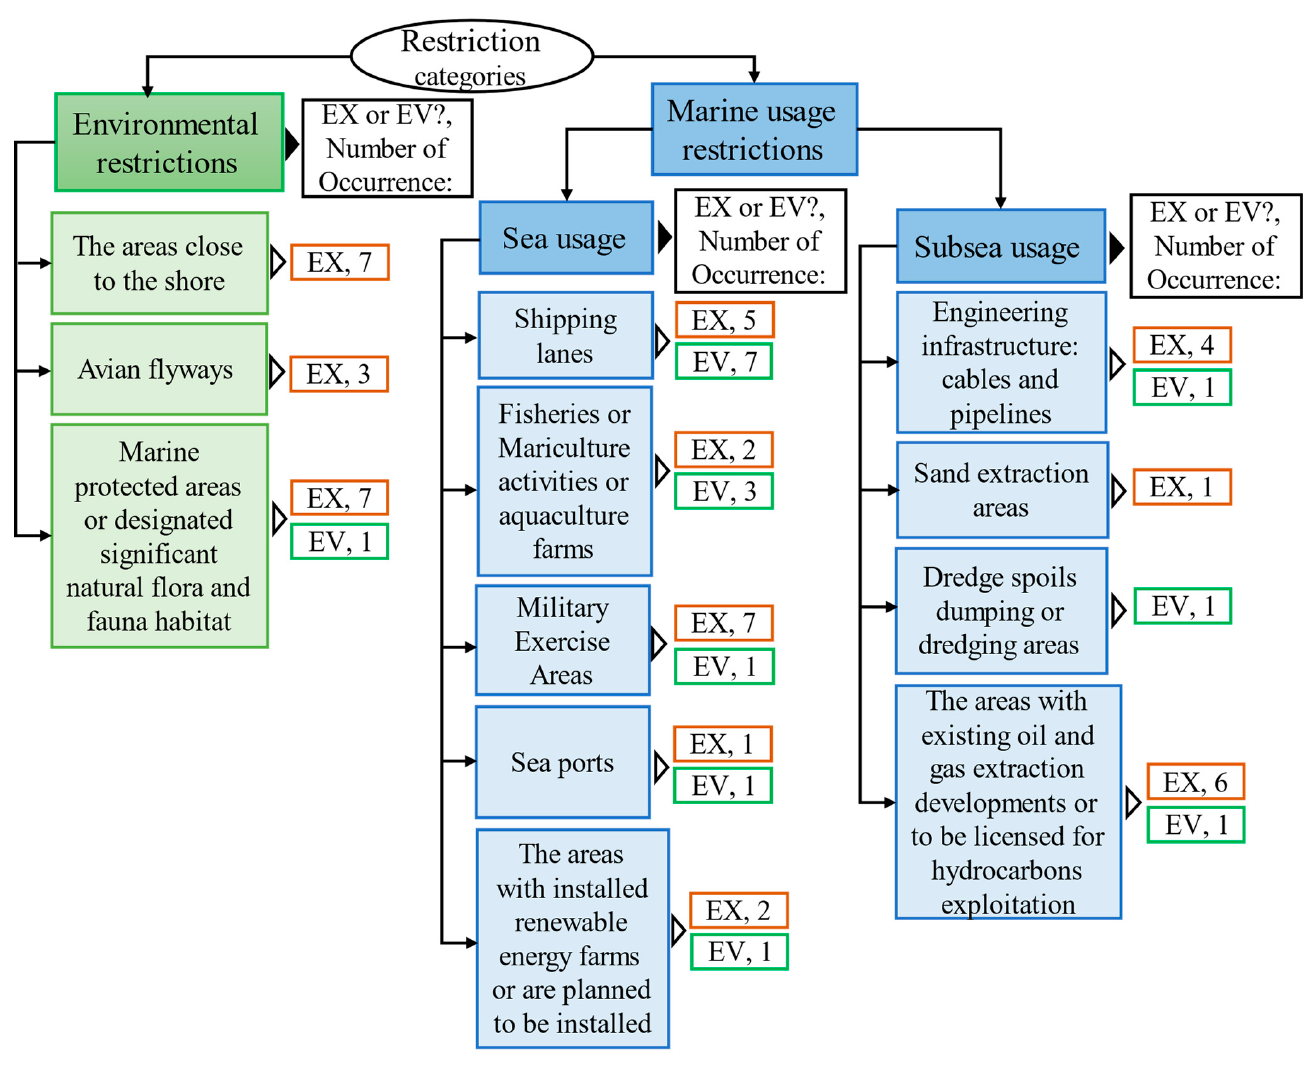
Figure 3. Graphical representation of restrictions (EX and EV refer to consideration type of criteria in literature, namely exclusion and evaluation, respectively).